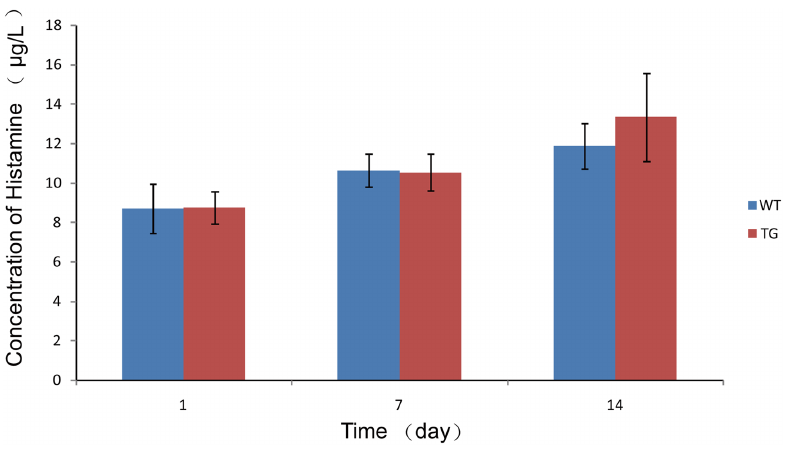
Fig 6. Detection of histamine in plasma of piglets. Data are means ± standard deviations. There was no significant difference in the histamine concentrations in the blood of piglets nursed by transgenic-cloned and WT sows (p >